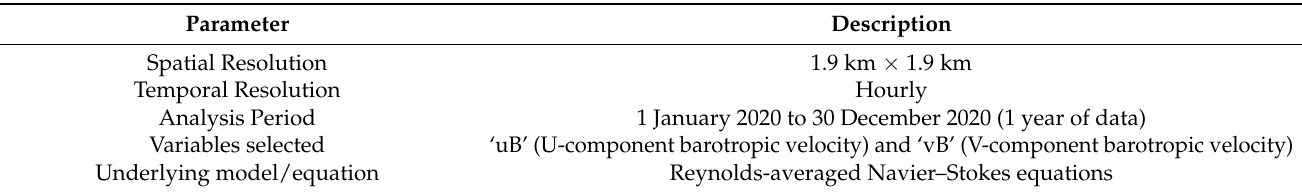
Table 3. Details of tidal data